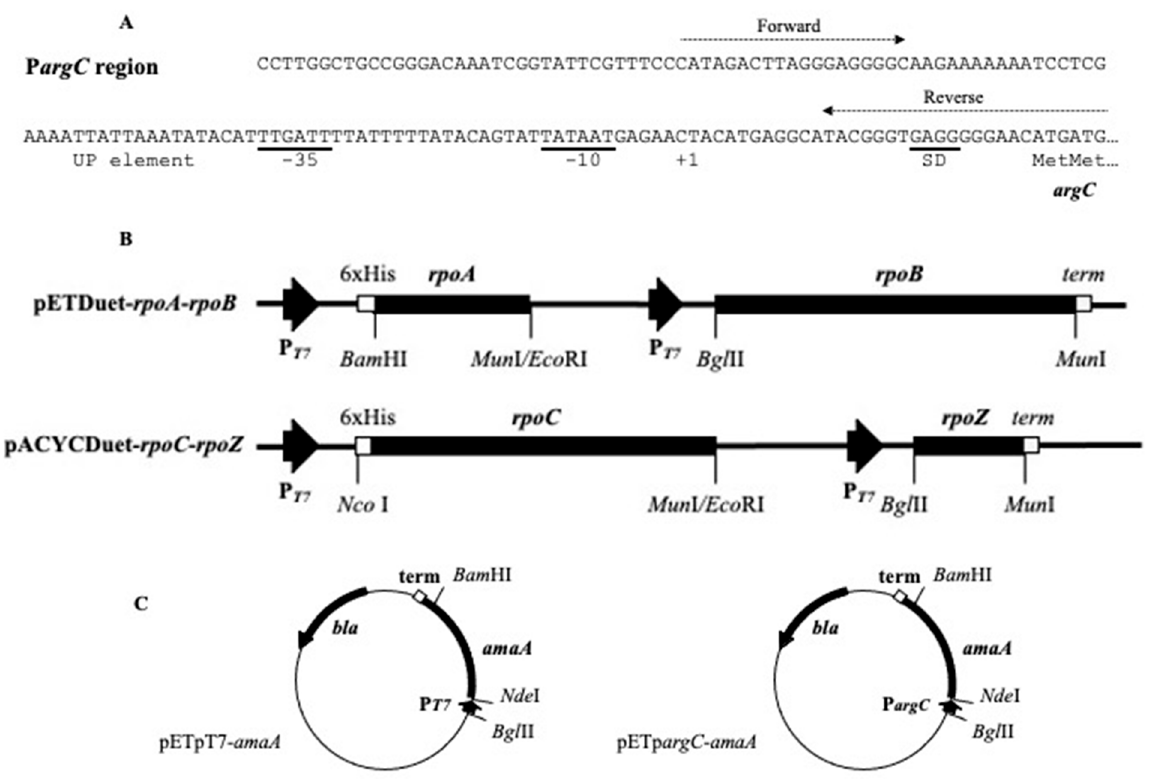
Figure 1. The G. stearothermophilus p argC region ( A ), the maps of recombinant plasmids carrying the E. coli rpo genes for core RNA polymerase ( B ) and the G. stearothermophilus amaA reporter gene ( C ). The sequence of the used p argC region is shown; dotted arrows show positions of forward and reverse primers used for PCR. In a couple of pET ‐ rpoA ‐ rpoB and pACYC ‐ rpoC ‐ rpoZ plasmids, the rpoA and rpoC gene code for N ‐ terminal His ‐ tag. Abbreviations: UP for UP ‐ element, SD for the site Shine ‐ Dalgarno, term for T7 transcription terminator.